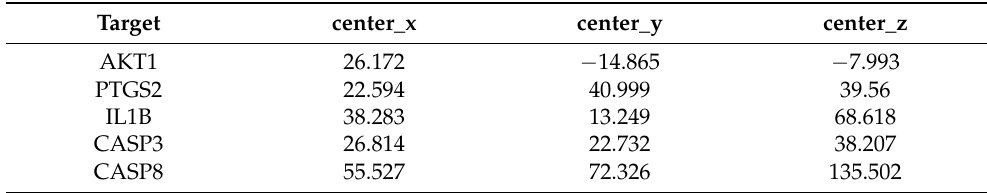
Table 1. Parameters of molecular docking between AR and